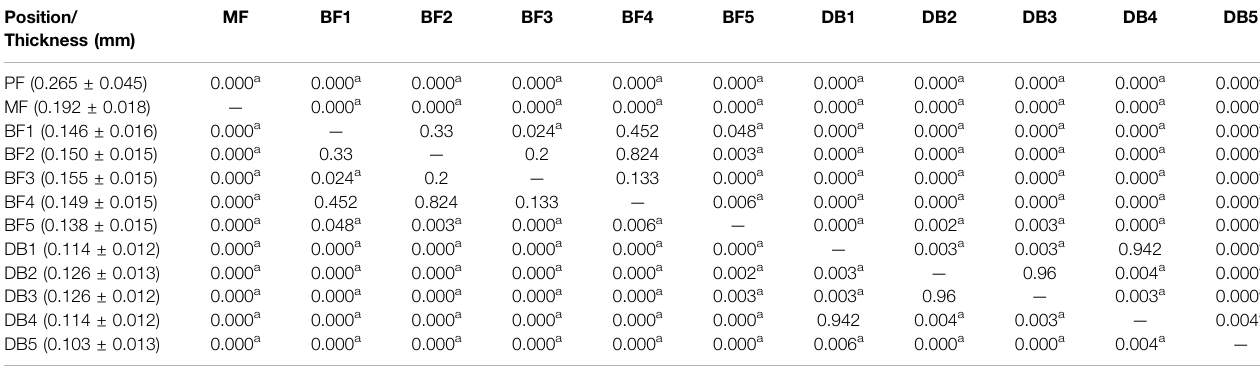
TABLE 2 | P value of least signi fi cant difference results between different positions in thickness of plantar fascia. Position/ Thickness (mm)